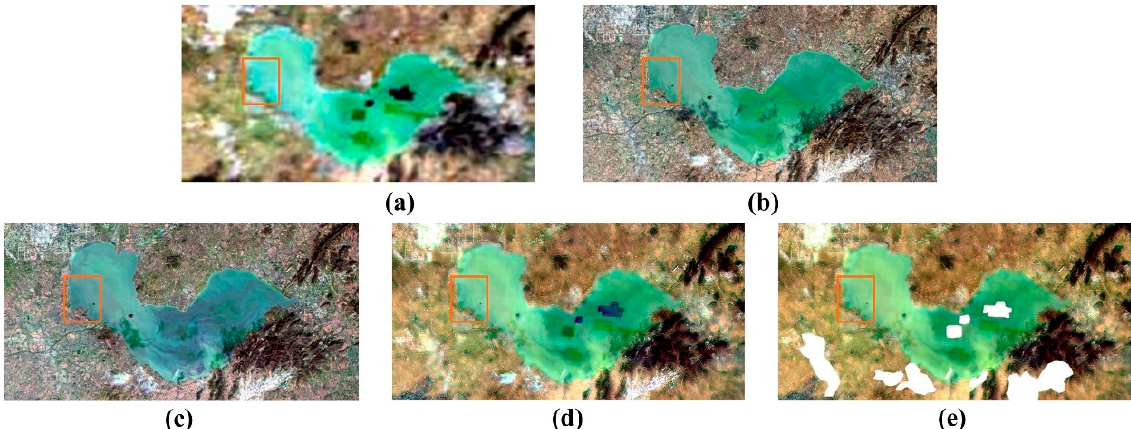
Figure 12. Visualized images in RGB on 28 December 2019. ( a – e ) The MODIS image, MSI image, fused image without the degradation model, fused image with the degradation model, and fused image with cloud masks, respectively. The cloudless pixels inside the yellow boxes were selected for comparative evaluation (the same as in Figure 6).